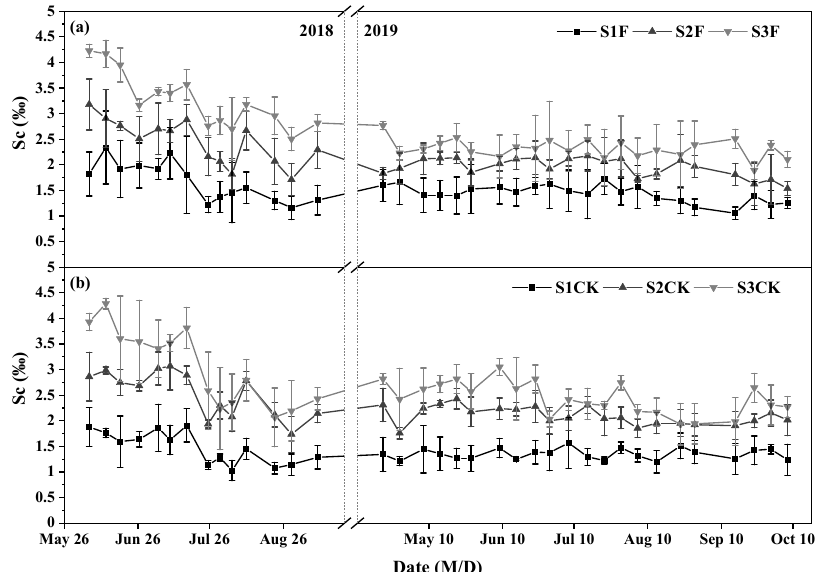
Figure 1. Seasonal variations of average soil salt content (Sc) of 0–100 cm for different treatments (S1f, S2f and S3F for ( a ) and S1CK, S2CK and S3Ck for ( b )) in 2018 and 2019. The error bars represent the standard deviation ( n = 3). S1F, S2F, and S3F indicate soil salt contents (wt/wt) 2‰, 4‰, and 6‰, respectively, with biosolids fertilizer; S1CK, S2CK, and S3CK indicate soil salt contents (wt/wt) 2‰, 4‰, and 6‰, respectively, with no biosolids fertilizer.